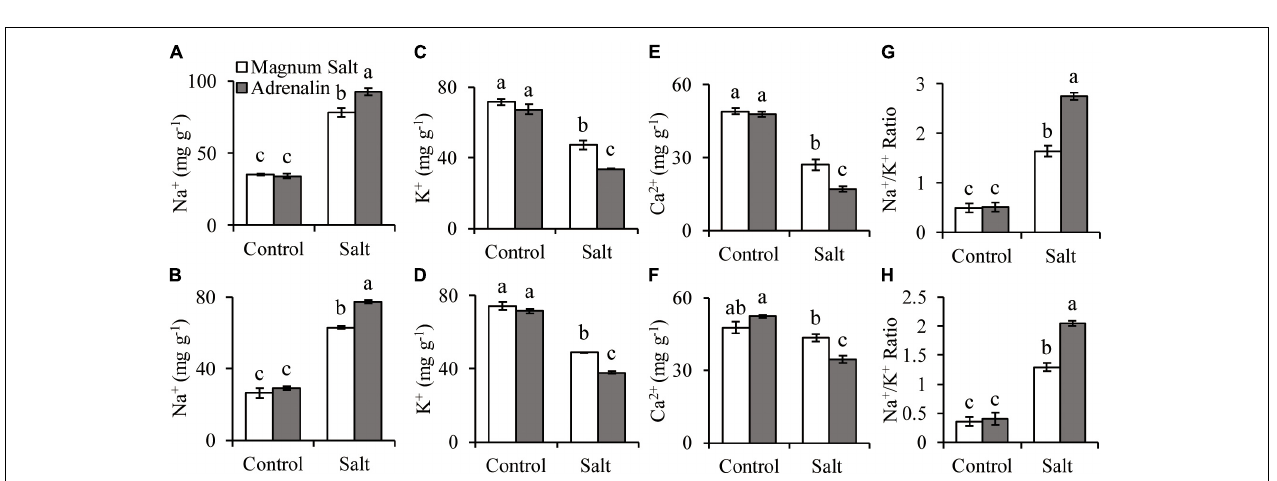
FIGURE 2 | Effect of salt treatment on the biomass of Magnum Salt and Adrenalin. Three-week old seedlings were treated with 1/2 Hoagland solution containing 0 or 150 mM NaCl for 1 week. Photographs (A) were taken and biomass of shoot (B) and root (C) were analyzed. Values are mean ± SE ( n = 10 replicates). Different letters indicate the significant differences ( P < 0.05, LSD) between two cultivars or treatments.